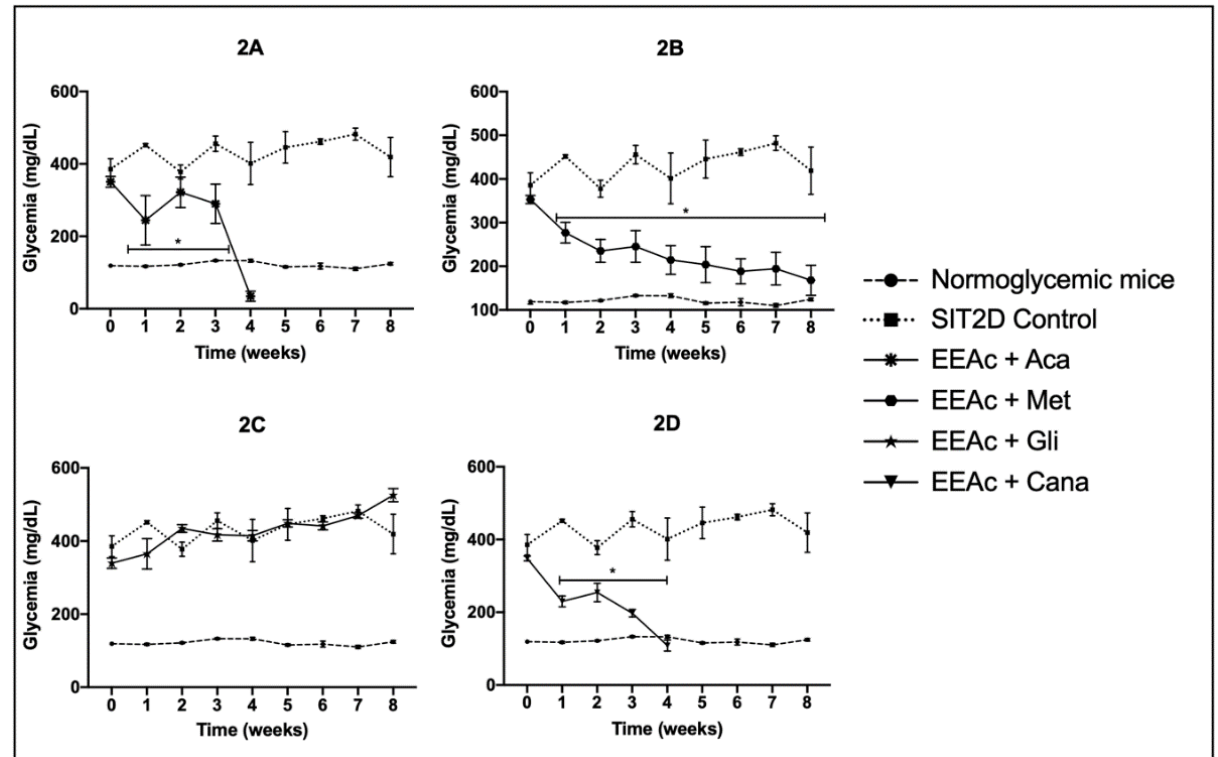
Figure 2. Effect over glycemic values of combined administration of the oral antidiabetic drugs with EEAc in SIT2D mice compared with SIT2D and normoglycemic control groups. Groups treated with EEAc 300 mg/kg + acarbose 50 mg/kg ( 2A ), EEAc 300 mg/kg + metformin 850 mg/kg ( 2B ), EEAc 300 mg/kg + glibenclamide 5 mg/kg ( 2C ), EEAc 300 mg/kg + canagliflozin 50 mg/kg ( 2D ). Results are